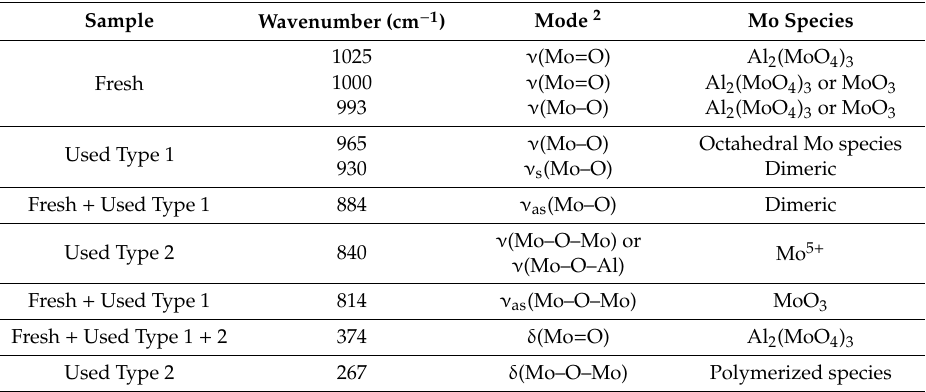
Figure 3. Raman spectra of hydrated fresh (before the reaction) and used (after the reaction cycle) catalysts at room temperature. Magnified region of the used catalyst—type 2 is shown in the inset. Table 2. Proposed assignments 1 of observed Raman